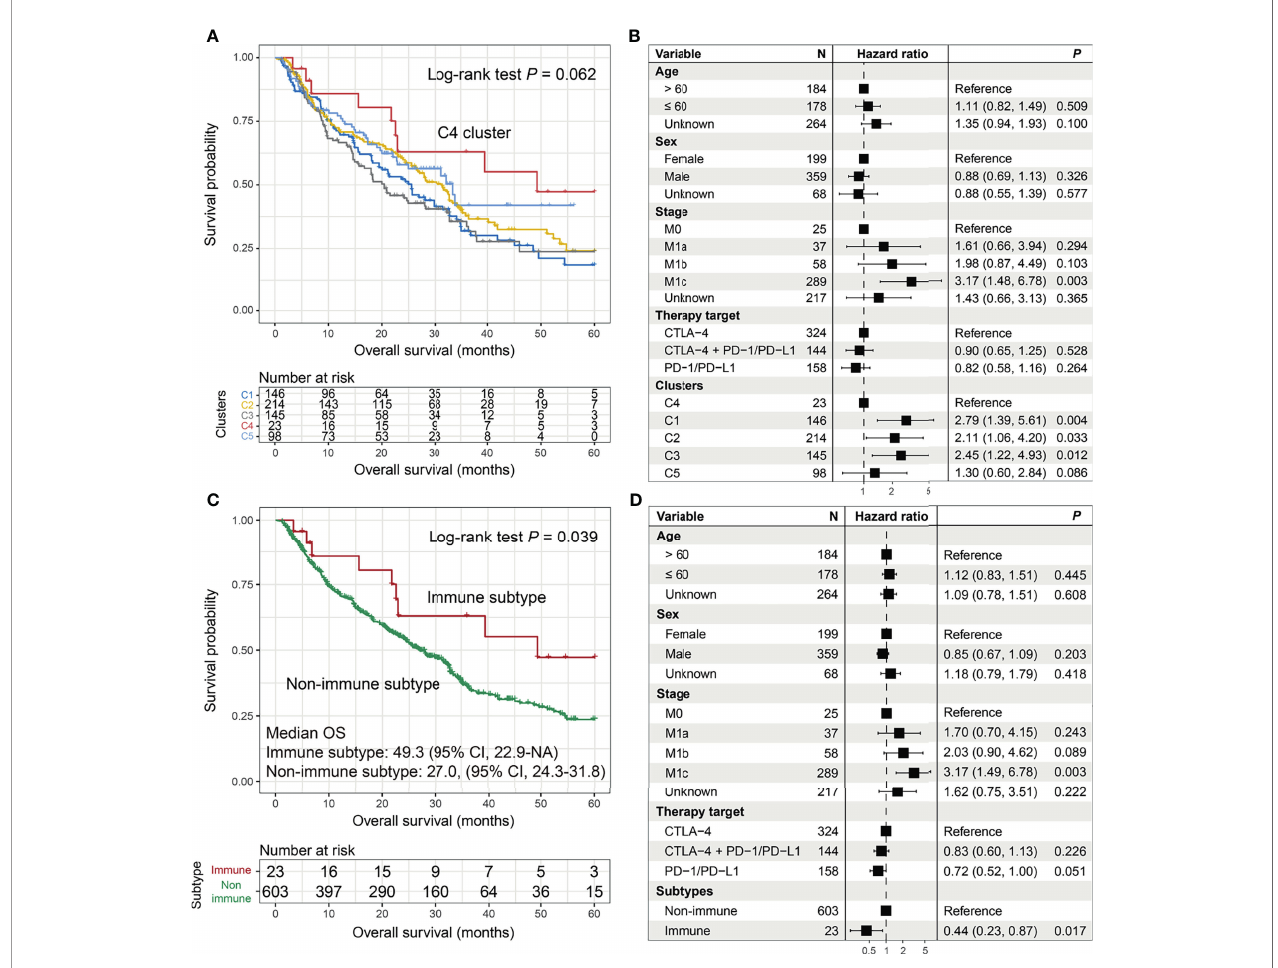
FIGURE 5 | The prediction roles of the identi fi ed melanoma immune subtype for immune checkpoint inhibitor (ICI) survival. (A) Kaplan – Meier survival analysis and (B) forest plot illustration of 5 clusters derived from the consensus clustering. Prognostic signi fi cances of the immune subtype vs. non-immune subtype under (C) Kaplan – Meier overall survival (OS) analysis and (D) multivariate Cox model with confounding variables taken into